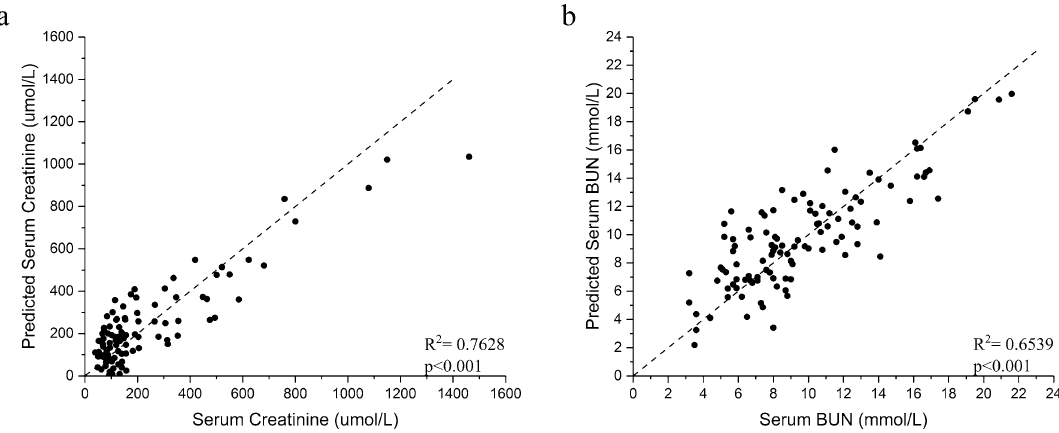
Figure 3. The PLS analysis generated models were used to predict the concentrations of blood biomarkers for kidney transplant function. The results showed that R 2 = 0.7628 for SCr ( a ) (p < 0.001) and R 2 = 0.6539 for BUN ( b ) (p < 0.001),